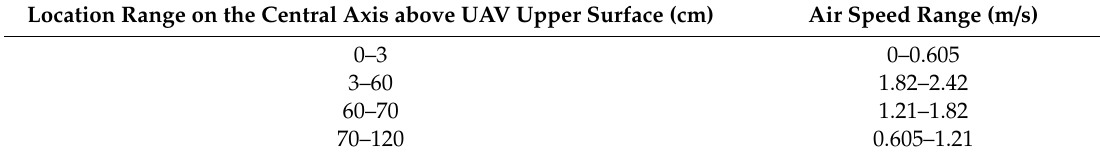
Table 3. Air speed range on the central axis above the unmanned aerial vehicle (UAV) upper surface. Location Range on the Central Axis above UAV Upper Surface